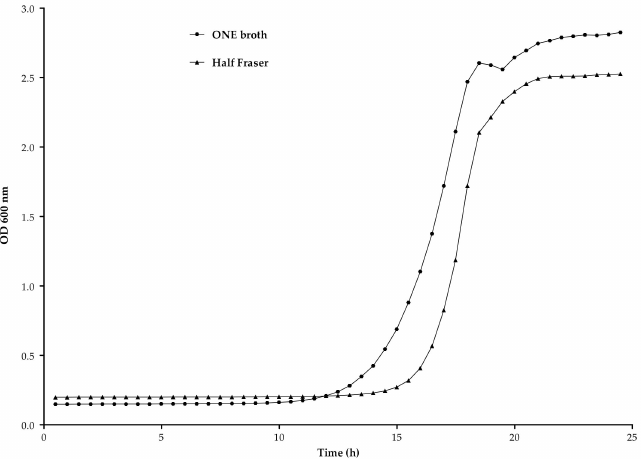
Figure 4. Comparison of L. monocytogenes growth kinetics in Half Fraser and ONE broth medium. Optical Density (OD) read at 600 nm, every 30 min, during 24 h at 30 ◦ C with constant